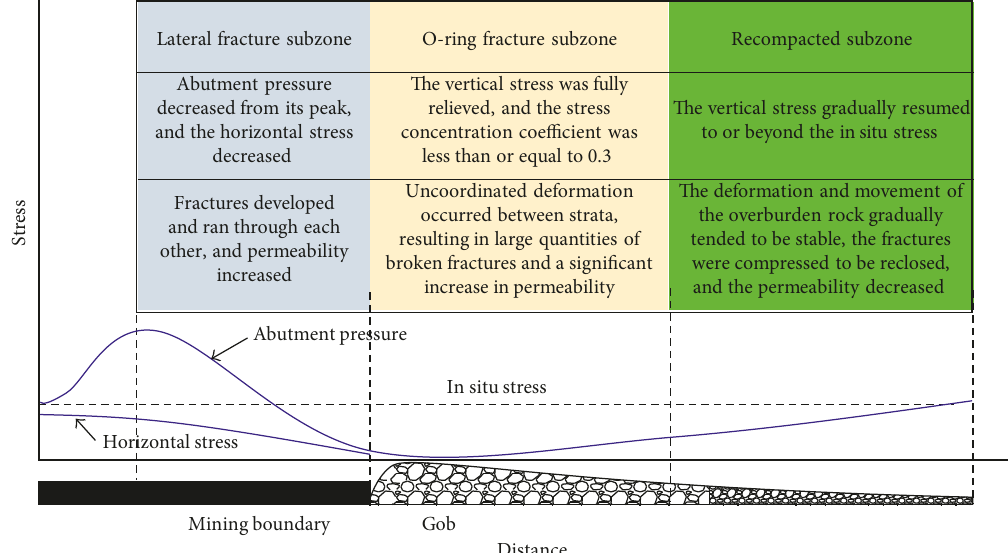
Figure 4: Influence of the variation in stress in coal rock masses on the development of mining-induced fractures.